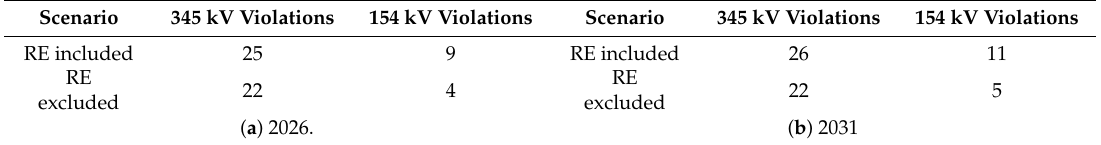
Table 7. The number of short-circuit capacity violations found via the short-circuit analysis.